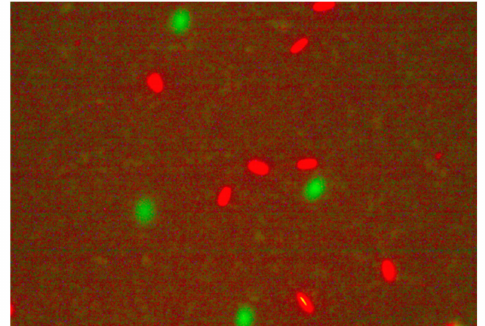
Figure 1. Spermatozoa with green heads were considered to have intact membranes, and spermatozoa with red heads were considered to have damaged